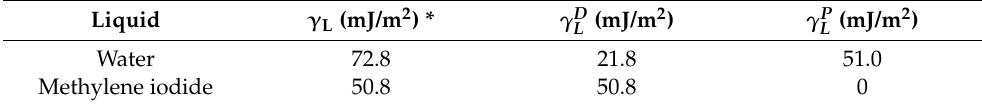
Table 1. The values of SFE and the dispersive and polar components of water and methylene iodide.